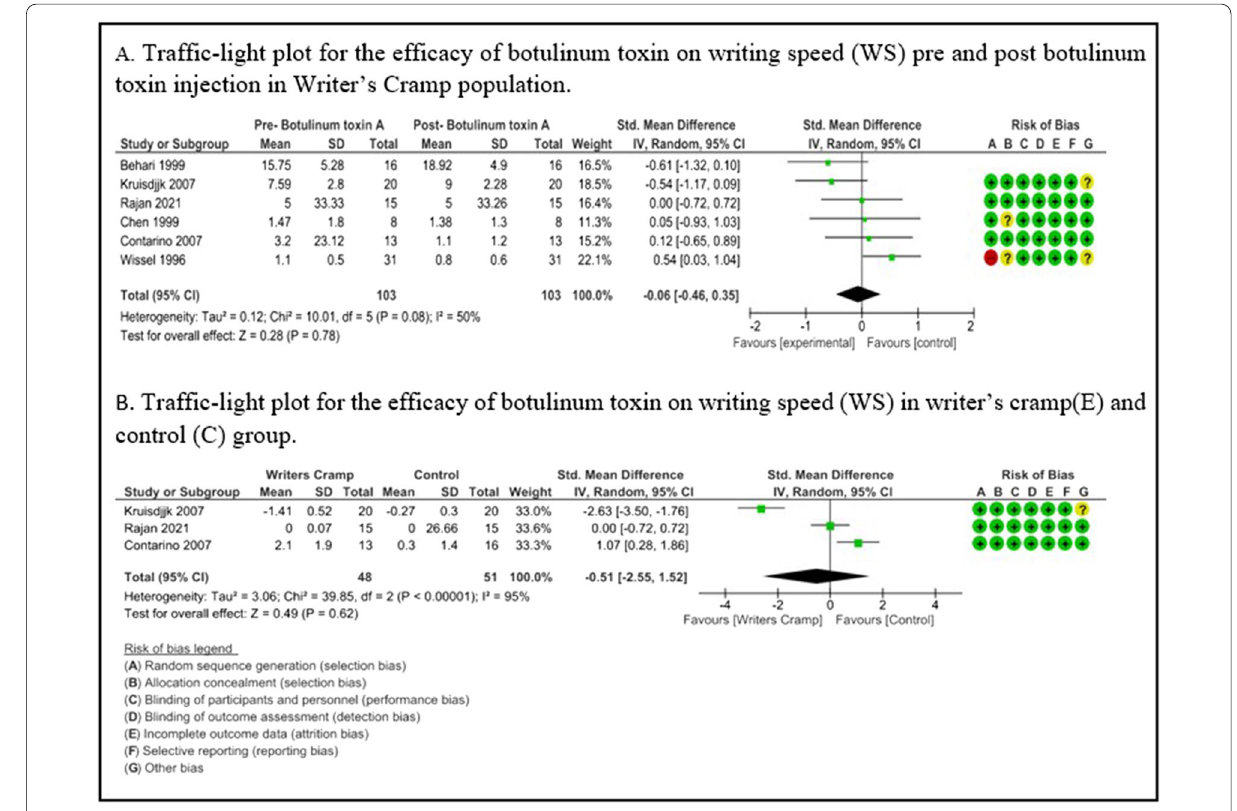
Fig. 3 Traffic light plot for the efficacy of pre and post botulinum toxin on WS in WC ( A ) and in ( B ) WC in